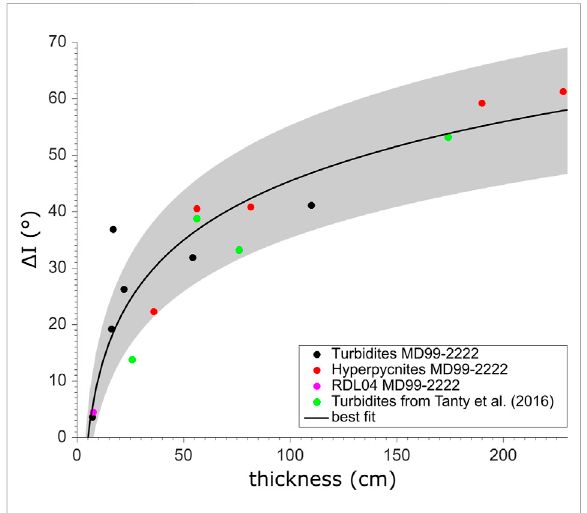
FIGURE 4 Amplitudeofinclinationchangeswithin16RDLsasafunction of their thickness. Black, red and pink closed circles are for turbidites, hyperpycnites and other RDLs from core MD99-2222, respectively. Green closed circles show the values of the four turbidites studied by Tanty et al. (2016).